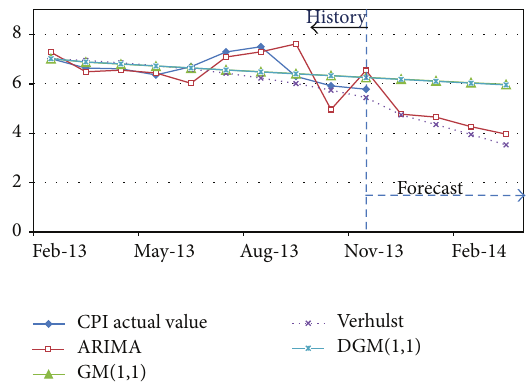
Figure 8: Actual and forecast CPI values for 04 models. Note: the DGM(2,1) values are not included.